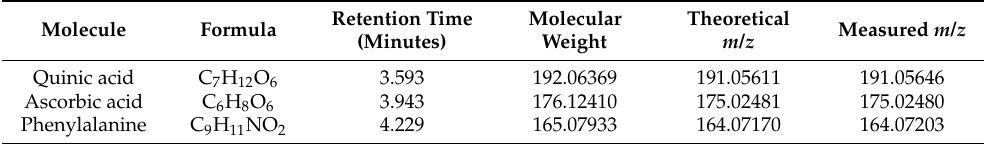
Table 2. Molecules identified in the chili extract by high-resolution mass spectrometry in negative ionization